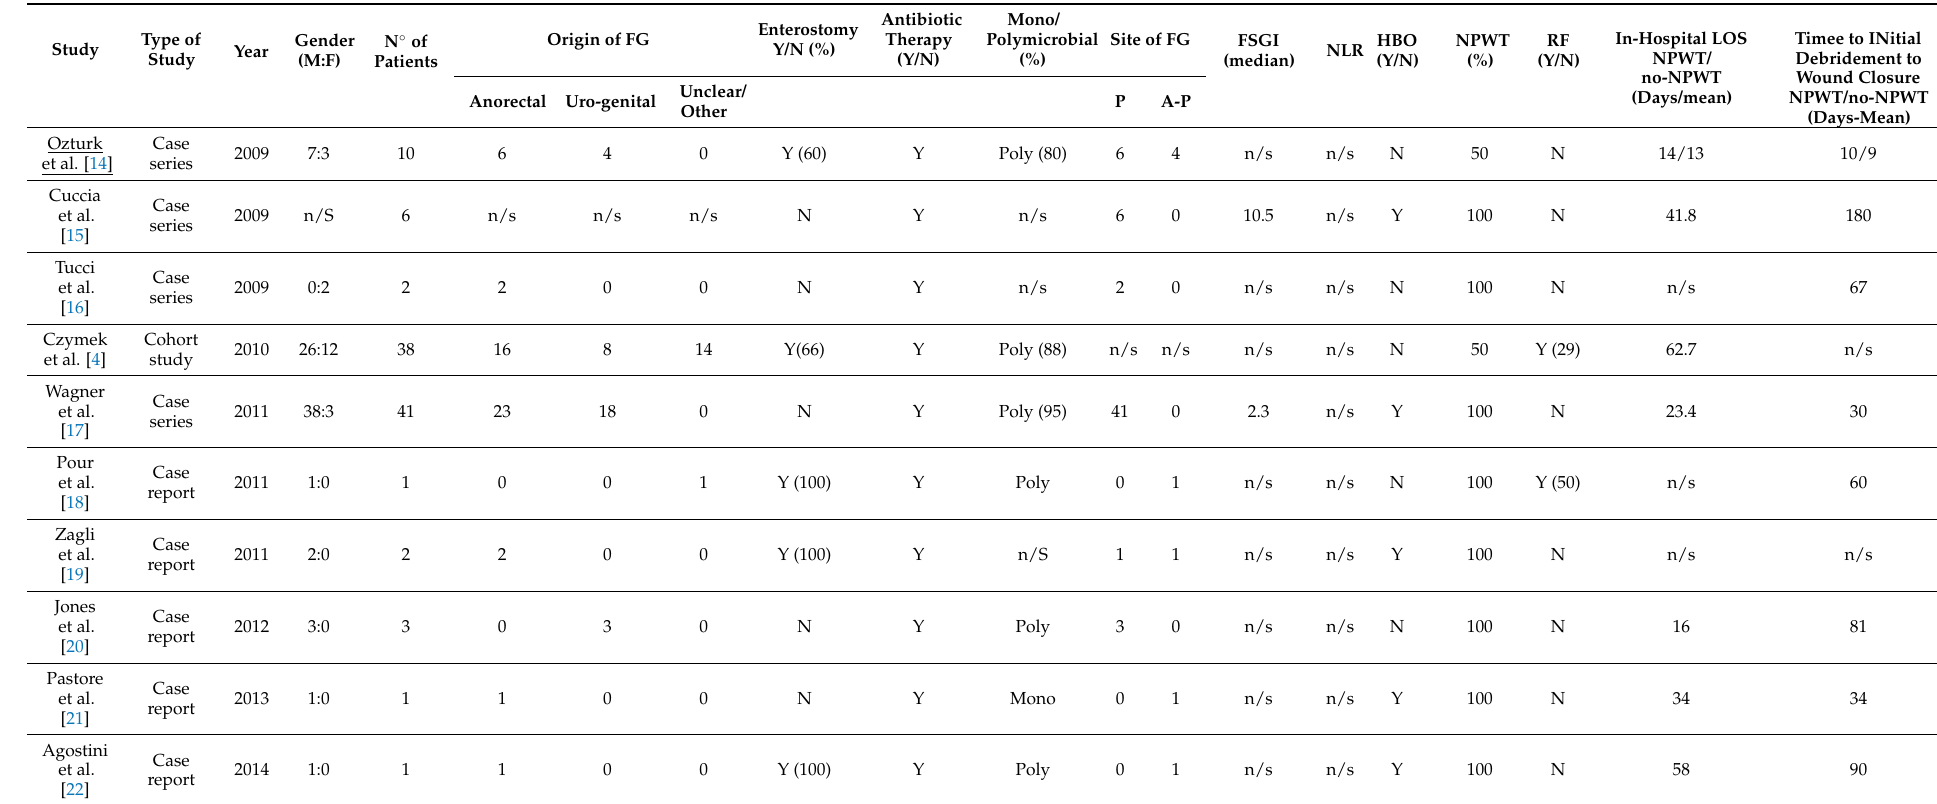
Table A1. Characteristics of included studies. CR: case report; CS: case series; Coh: cohort study; AR: anorectal; UG: urogenital; Und: undefined; Poli: polymicrobial; Mono: monomicrobial; Conf: confined; Dissem: Disseminated; N/s: not-specified; data presented as “a/b” refers to “VAC group vs. Conventional dressing group”; NSTI: Necrotizing Soft Tissue Infections; HBO: Hyperbaric Oxygen. RF: rectal fistula. NLR: Neutrophil/Lymphocyte ratio. NPWT: negative pressure wound therapy. All the studies treated the patient with surgical debridement and antibiotics therapy. Gul et al. reported a percentage of FGSI > 9, dividing both groups one high-risk and